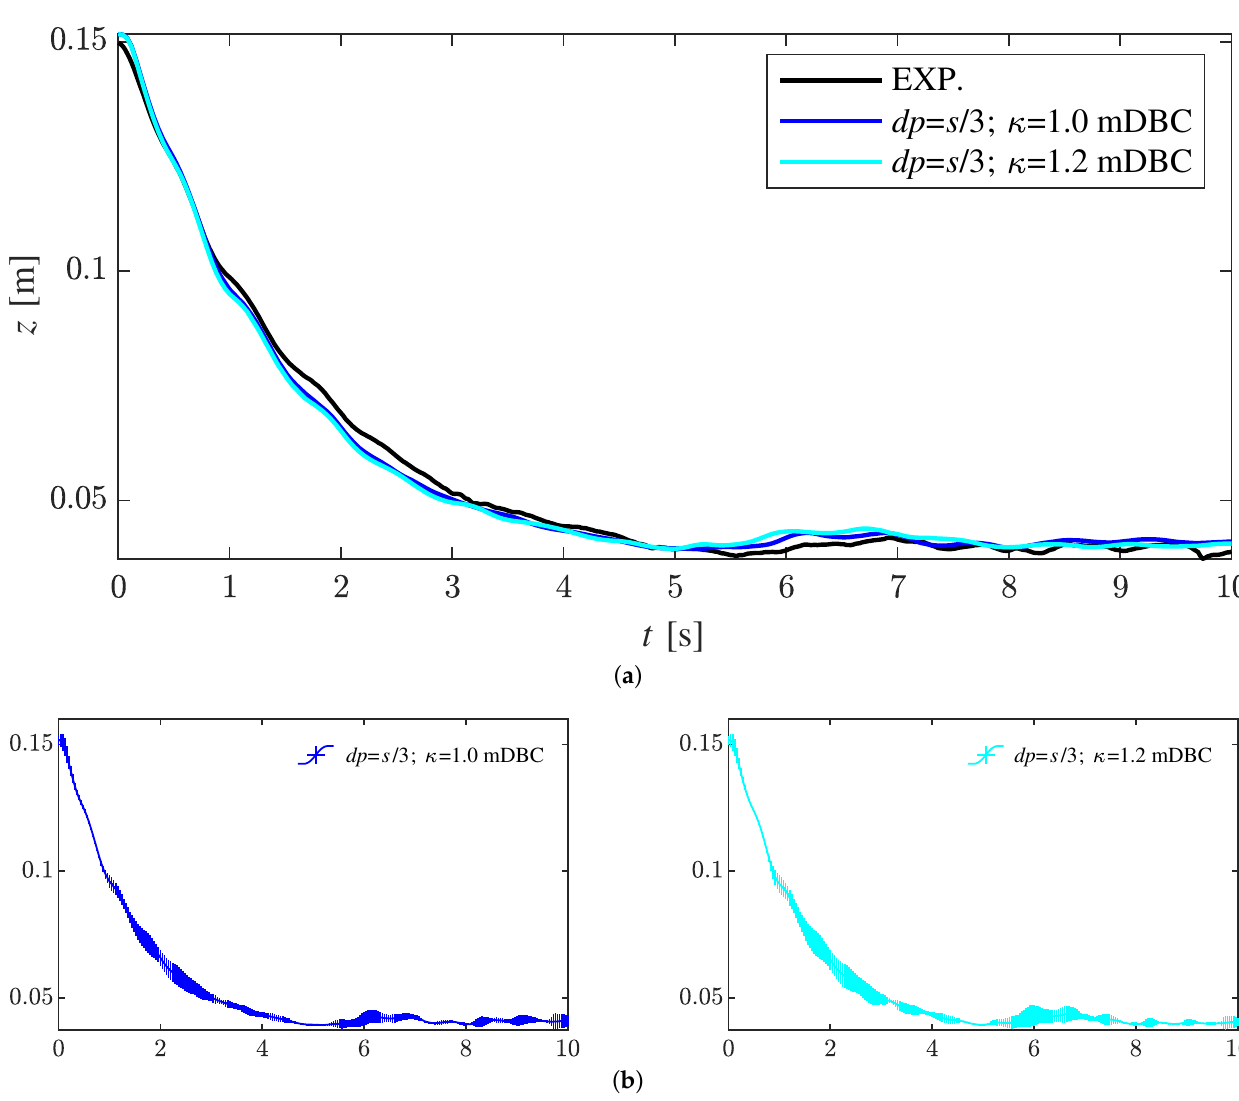
Figure 5. Comparison at P1 ( a ) and relative local elevation error ( b ) with dp = s /3 and different values of κ